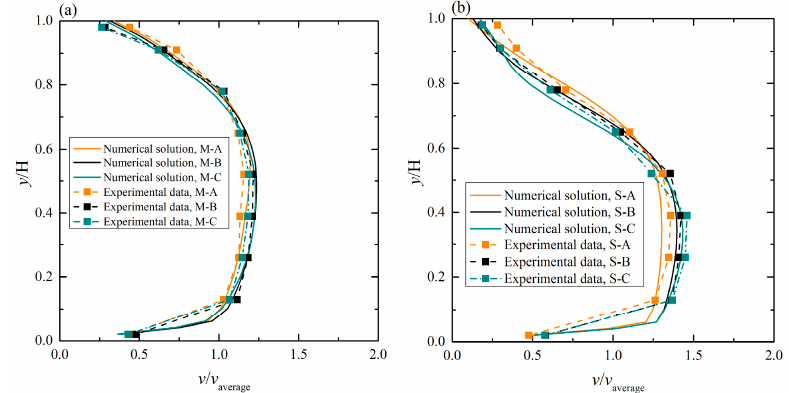
Figure 8. Validation for the velocity distribution in the inflow condition: ( a ) middle orifice; ( b ) side orifice.